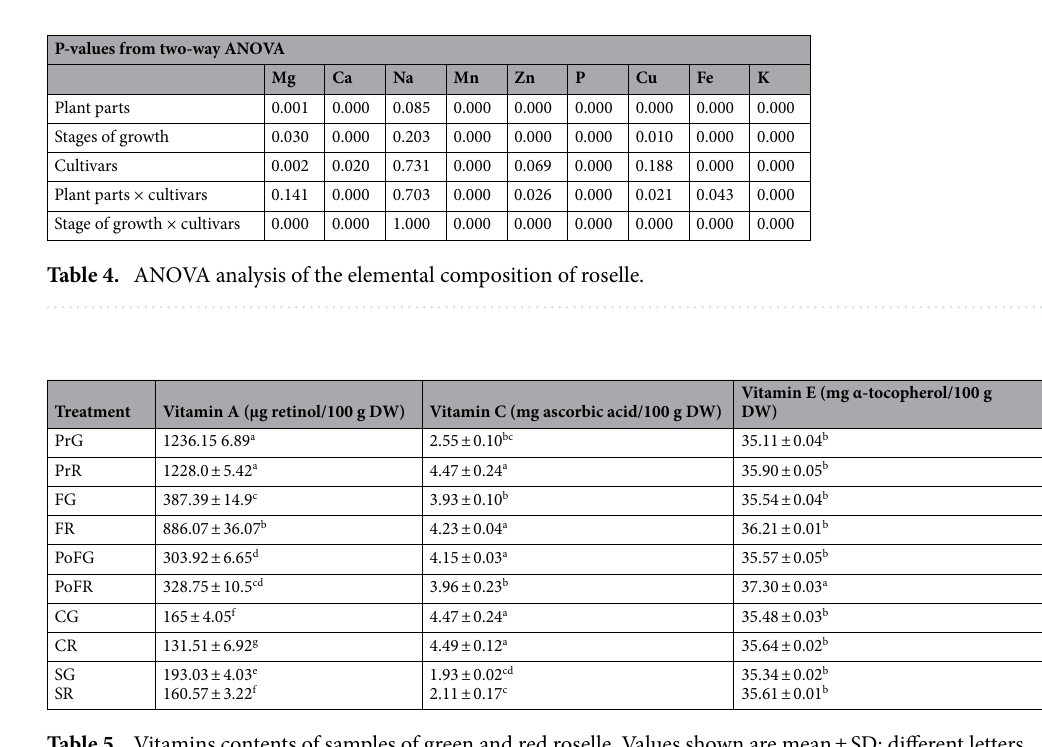
Vitamin C content in the samples ranged from 1.93 ± 0.02 to 4.49 ± 0.12 mg ascorbic acid/100 g DW. Although the value in red calyces was the highest, vitamin C contents in both calyces and leaves were higher than the values in the seeds. At the highest concentration (1 mg/ml), vitamin C absorbance value for ascorbic acid—standard (0.2487) was lower than the absorbance values of all the extracts which were all more than 1.000. All the treat- ments were a better source of vitamin C than ascorbic acid. Vitamin E content in the treatments ranged from 35.11 ± 0.04 to 37.30 ± 0.03 mgα tocopherol/100 g DW. Although Vitamin E content in post-flowering red was higher, all other treatments had equal values (Table 3a). The value of vitamin E standard at a concentration of 1 mg/ml (3.7553) was far higher than the values in all the treatments which ranged from 0.5947 in post-flowering red to 0.1907 in pre-flowering green. Roselle contains low vitamin E value (Table 5).